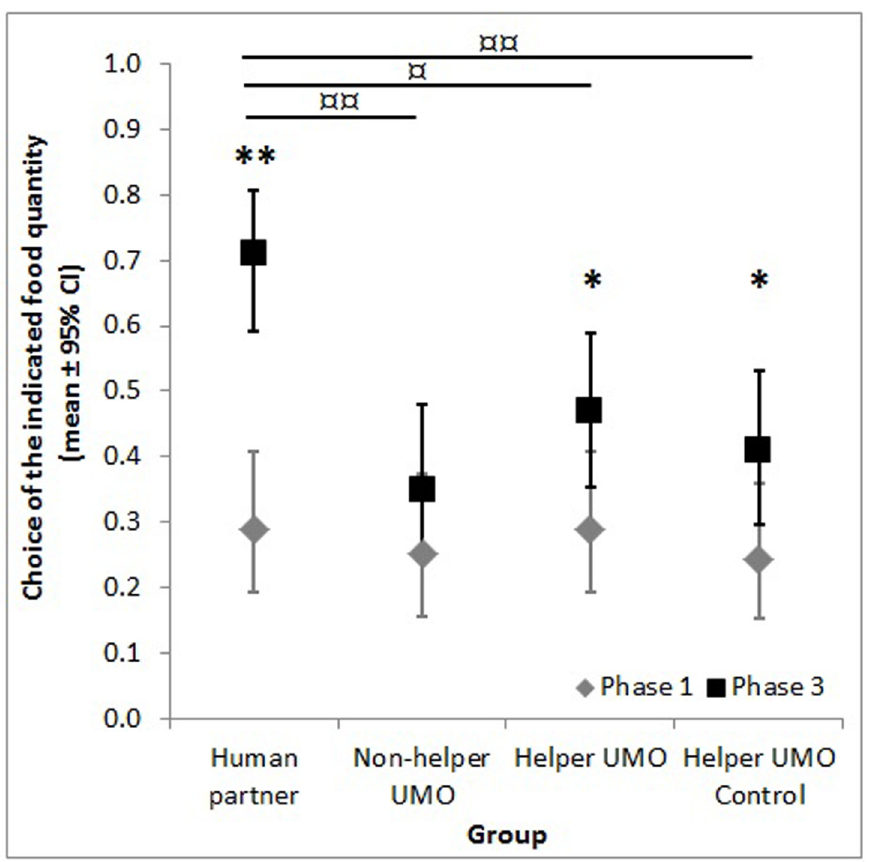
Fig 2. Choice of the small food quantity in Phase 1 and 3. Data are only from dogs who chose the larger quantity more often (Phase 1) and the partner indicated the small food quantity in Phase 3; * shows the difference between phases, ¤ shows the difference between groups in Phase 3 ( * p < 0.05, ** p < 0.001, ¤ p < 0.01, ¤¤ p <